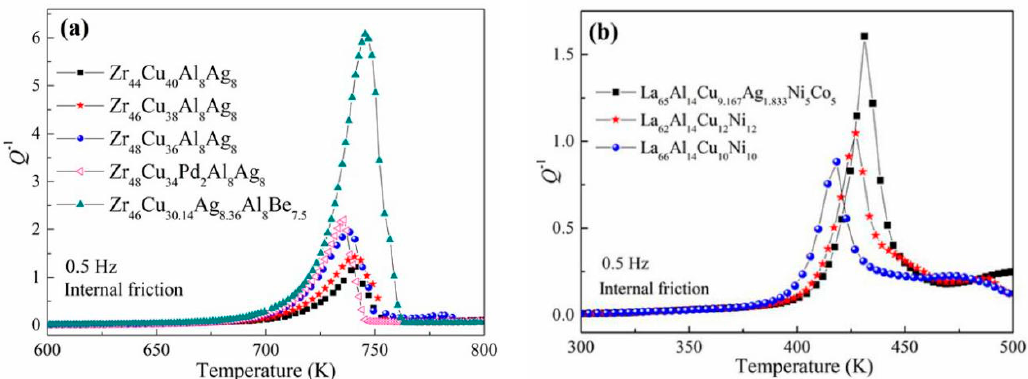
Figure 4. ( a ) Q − 1 – T curves of a series of Zr-based BMGs with a driving frequency of 0.5 Hz; ( b ) Q − 1 – T curves of a series of La-base BMGs with a driving frequency of 0.5 Hz. Table 2. The GFA value (determined by the critical parameter [28–31]), IF peak values ( Q p − 1 ) with a driving frequency of 0.5 Hz, and inflection point IF values ( Q i − 1 ) with a driving frequency of 0.5 Hz of Zr-based BMGs and La-based BMGs.